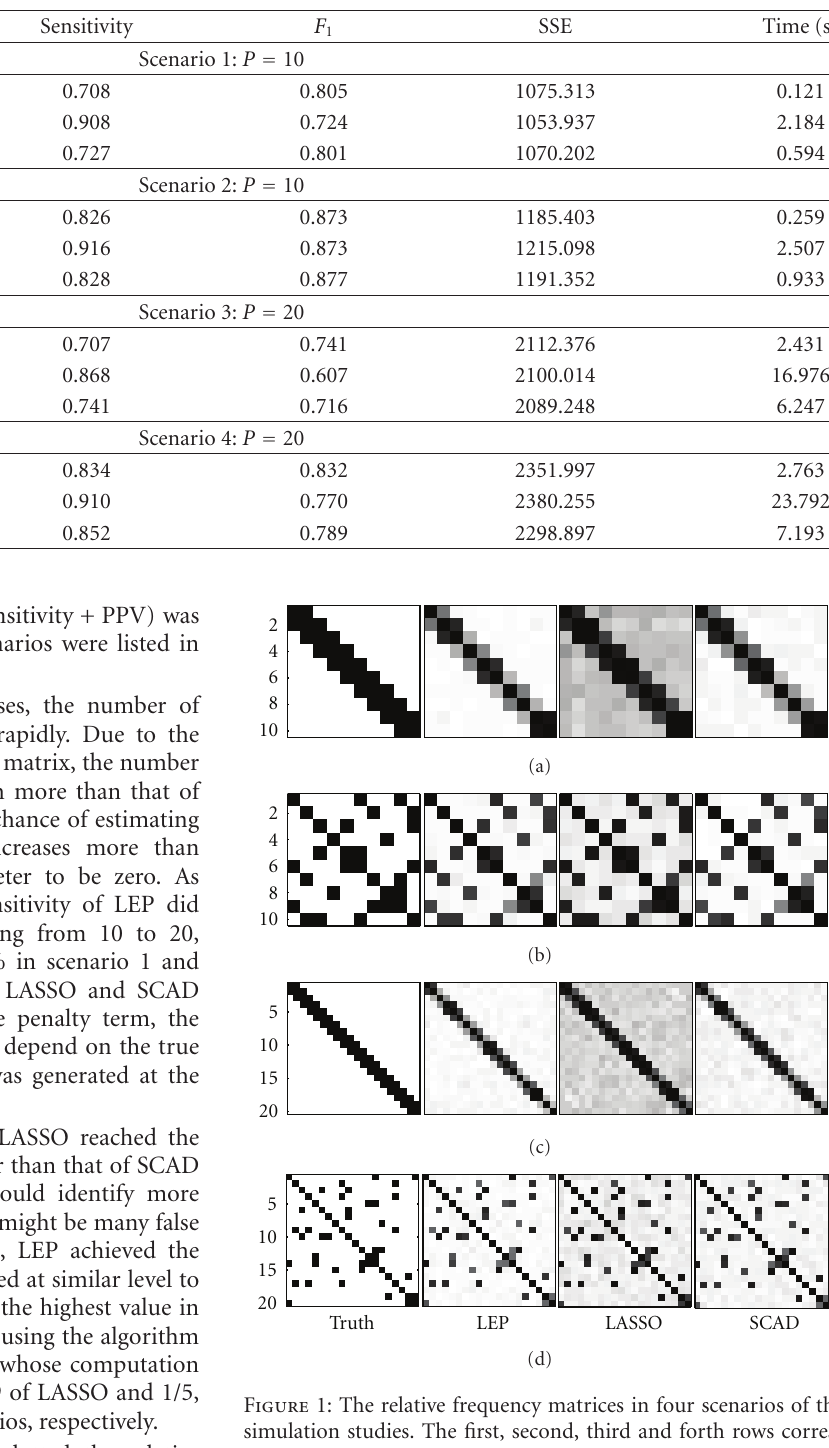
Table 1: The sensitivity, PPV, and F 1 values in four scenarios of the simulation studies.